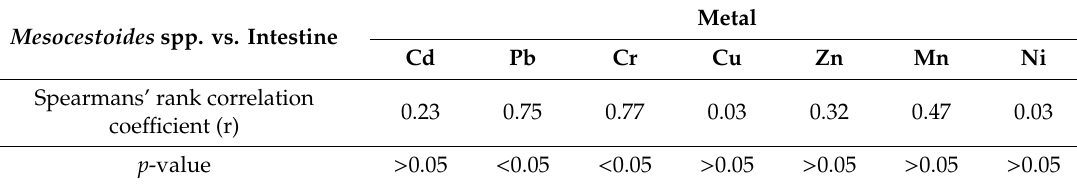
Table 2. Dependence of heavy metal concentrations in Mesocestoides spp. on heavy metal contents in the intestine.